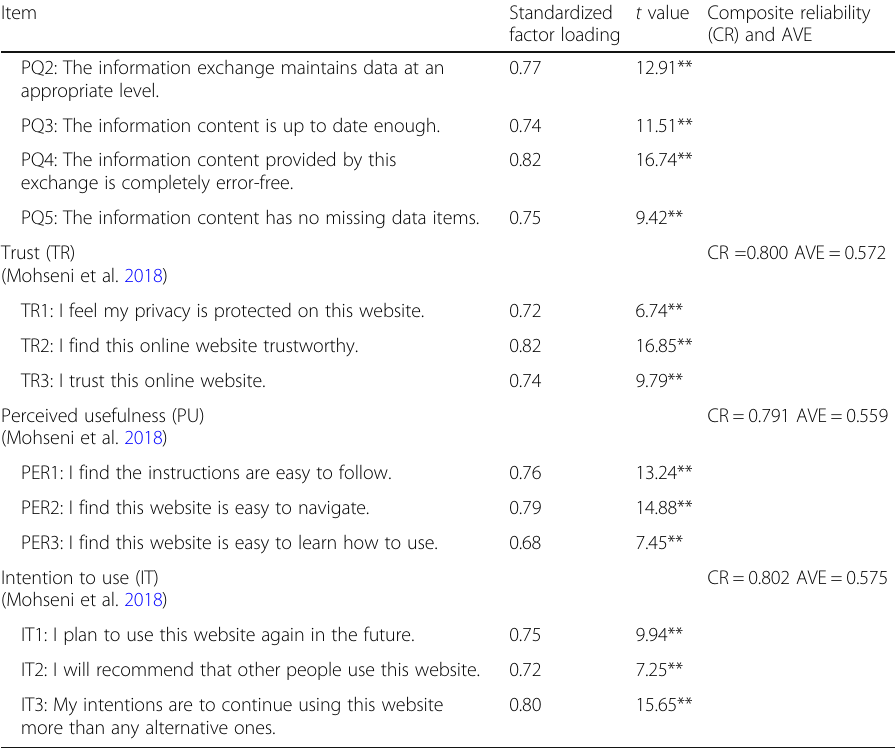
Table 2 Reliability assessment of the measurement model (Continued) Item Standardized